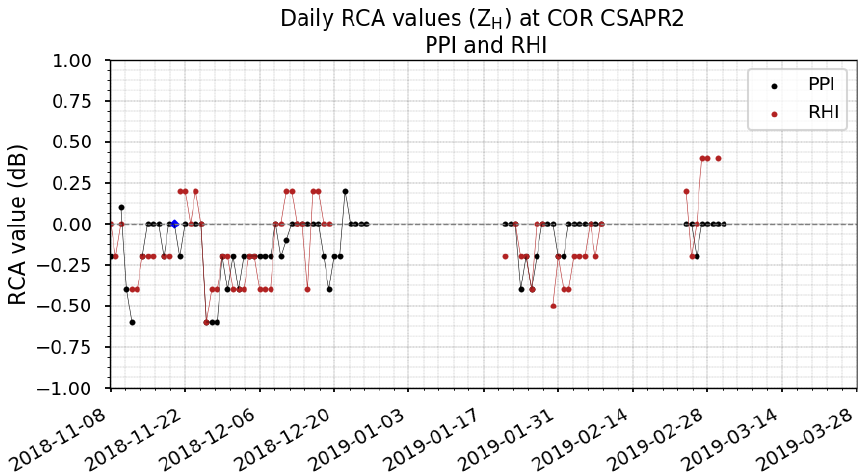
Figure 12. RCA time series for CSAPR2 PPIs and RHIs at the COR site during CACTI. RCA calculated using the composite clutter maps and 20 November 2018 as the baseline. The two radars are within the statistical noise of the eRCA technique. The gaps in the time series are due to periods where the radar was offline.